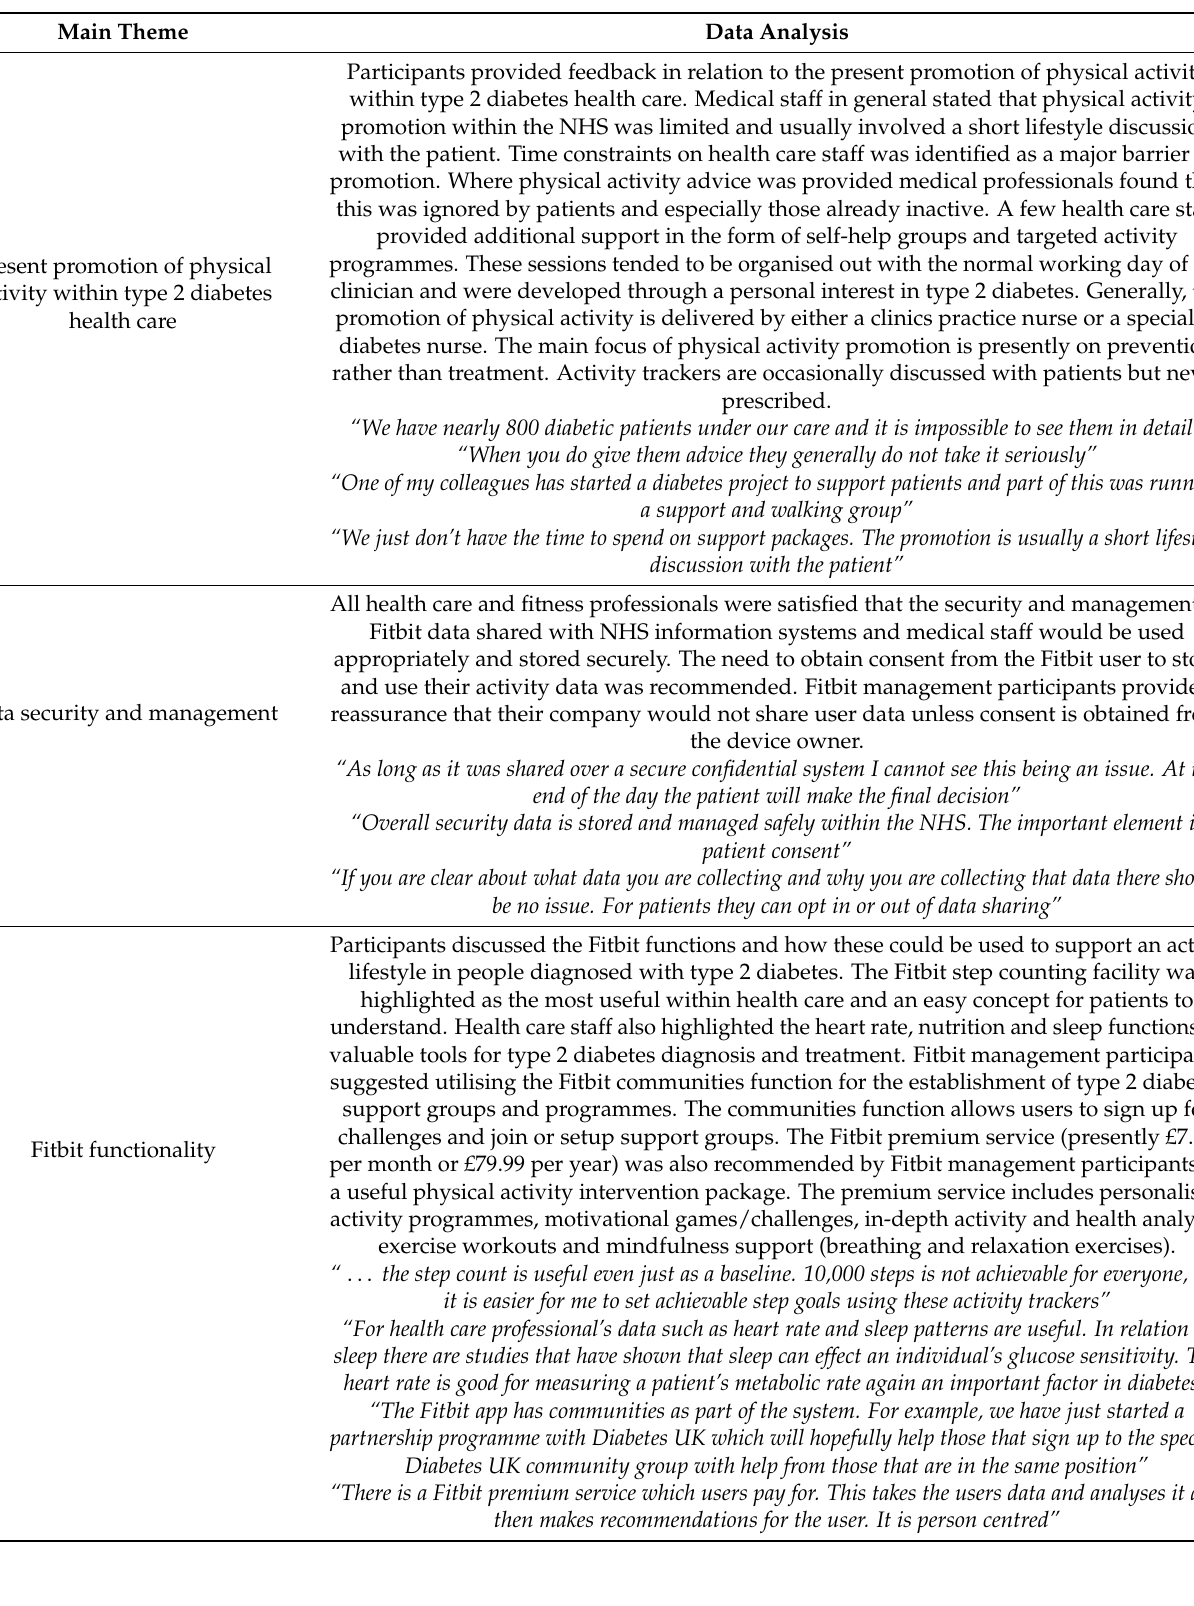
Table 5. Detailed analysis of stage 2 main